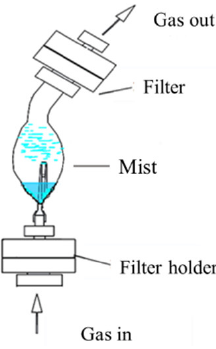
Figure 3. Sampling device diagram.